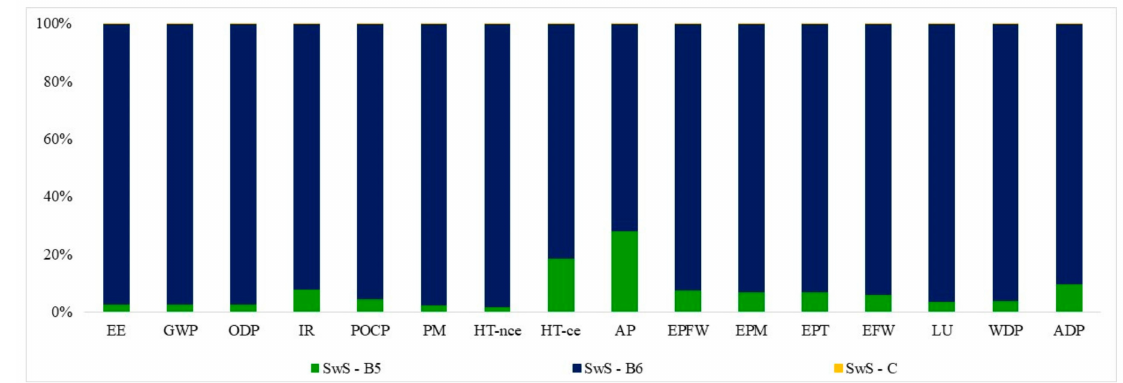
Figure A7. Contribution of the different phases to the life cycle impacts—SwS (1970–1989).